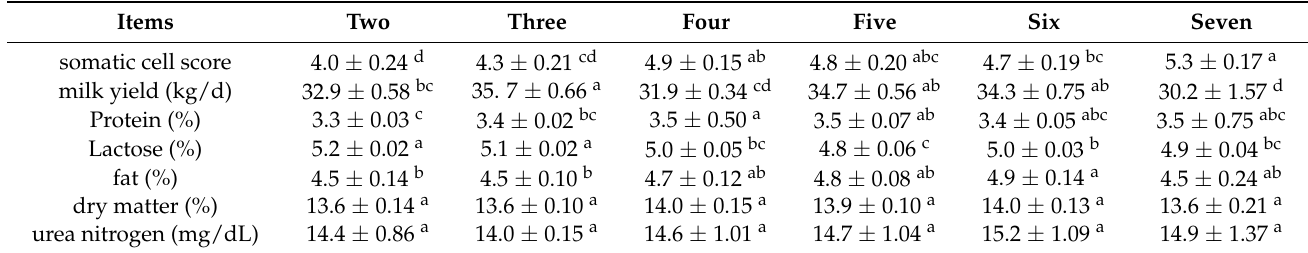
Table 4. DHI changes of Holstein cows at different ages.